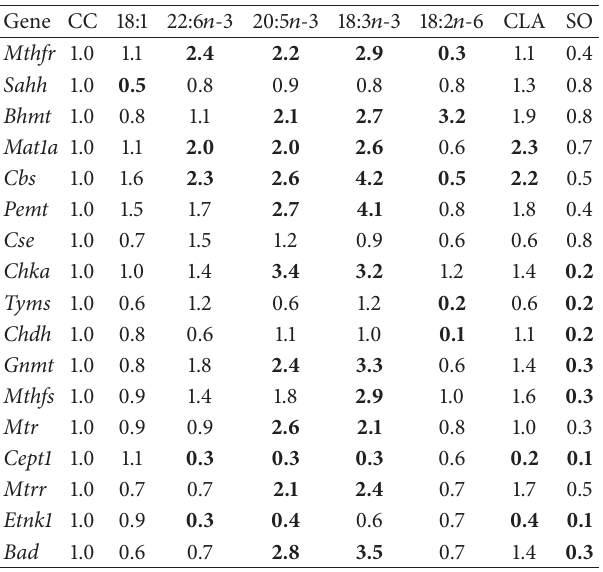
Table 4: Gene expression of the critical genes involved in Hcy and phospholipids metabolism